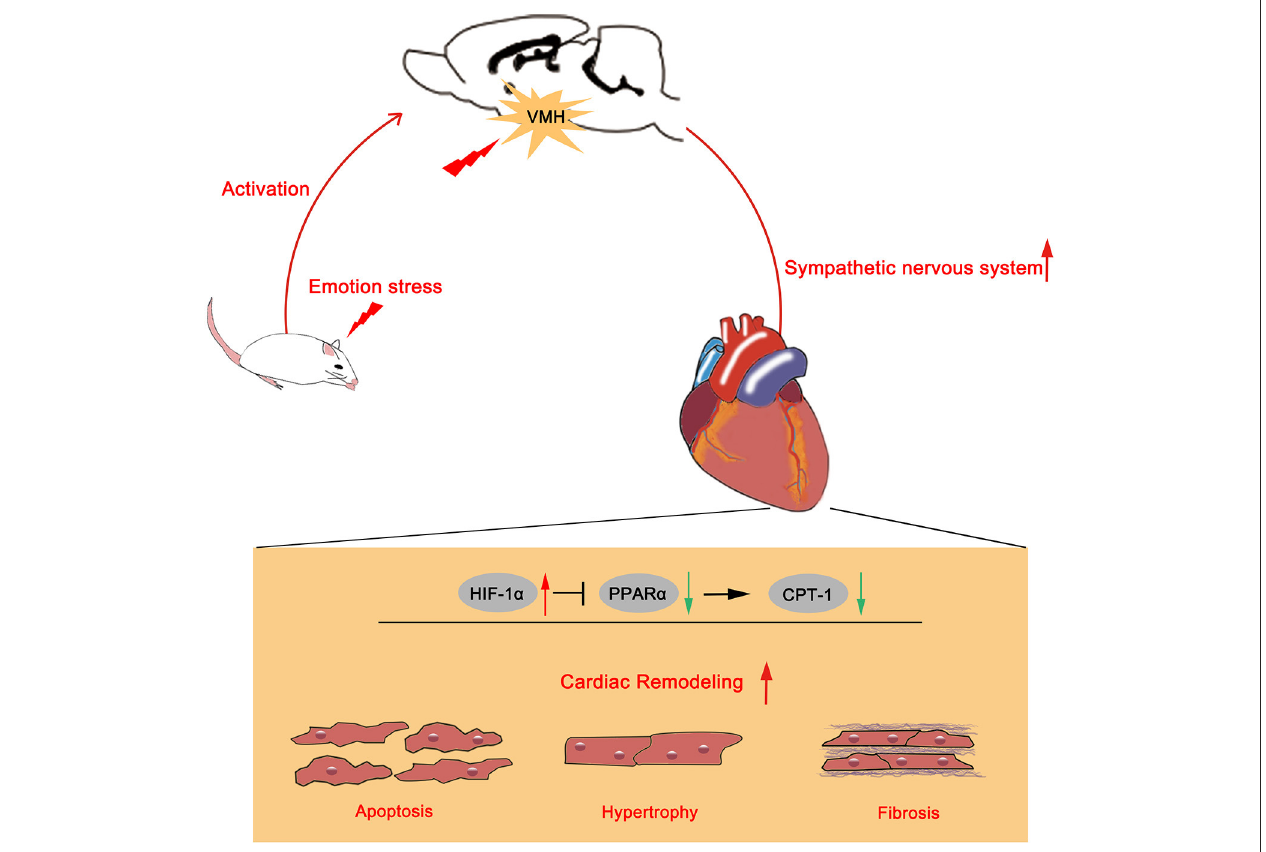
FIGURE 6 | Schematic summary of the effects of VMH activation in HTN hypertension model. Emotional stress caused VMH activation could increase sympathetic nervous system activity. Upregulated sympathetic activity might increase HIF-1 α expression and reduced PPAR α and CPT-1 expression, then aggravated cardiac